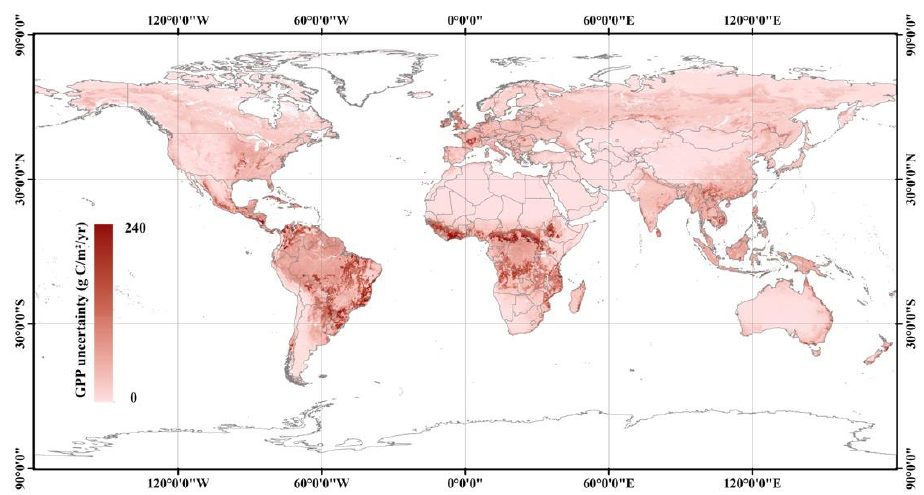
model from 2001 to 2018.